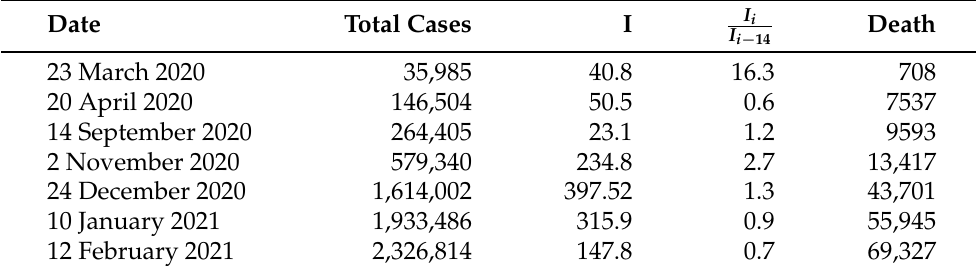
Table 8. Data for Germany: Total cases, Cases per 100,000 inhabitants in the last 14 days, rate of Cases in the last 14 days and the previous 14 days interval, Death related to COVID-19.